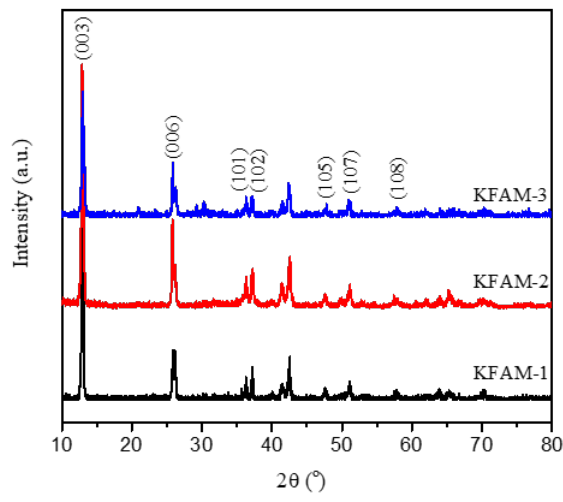
Figure 1. XRD patterns of KFAM-X.